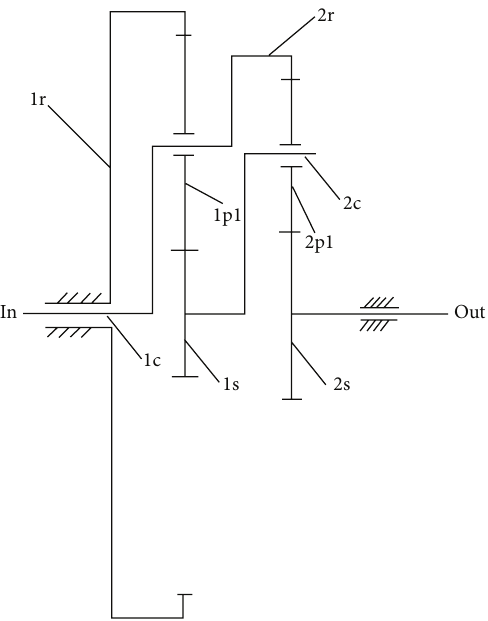
Figure 1: Kinematic scheme of load-split two-stage planetary